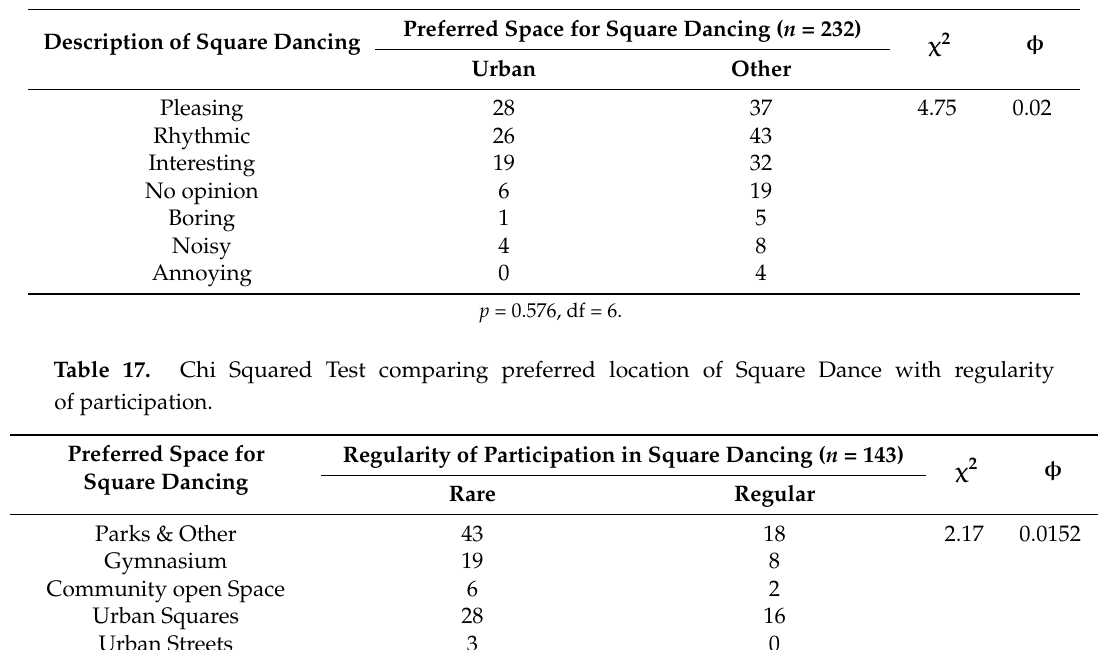
Table 16. Chi Squared Test comparing description of square dance to the preferred location of Square Dance.